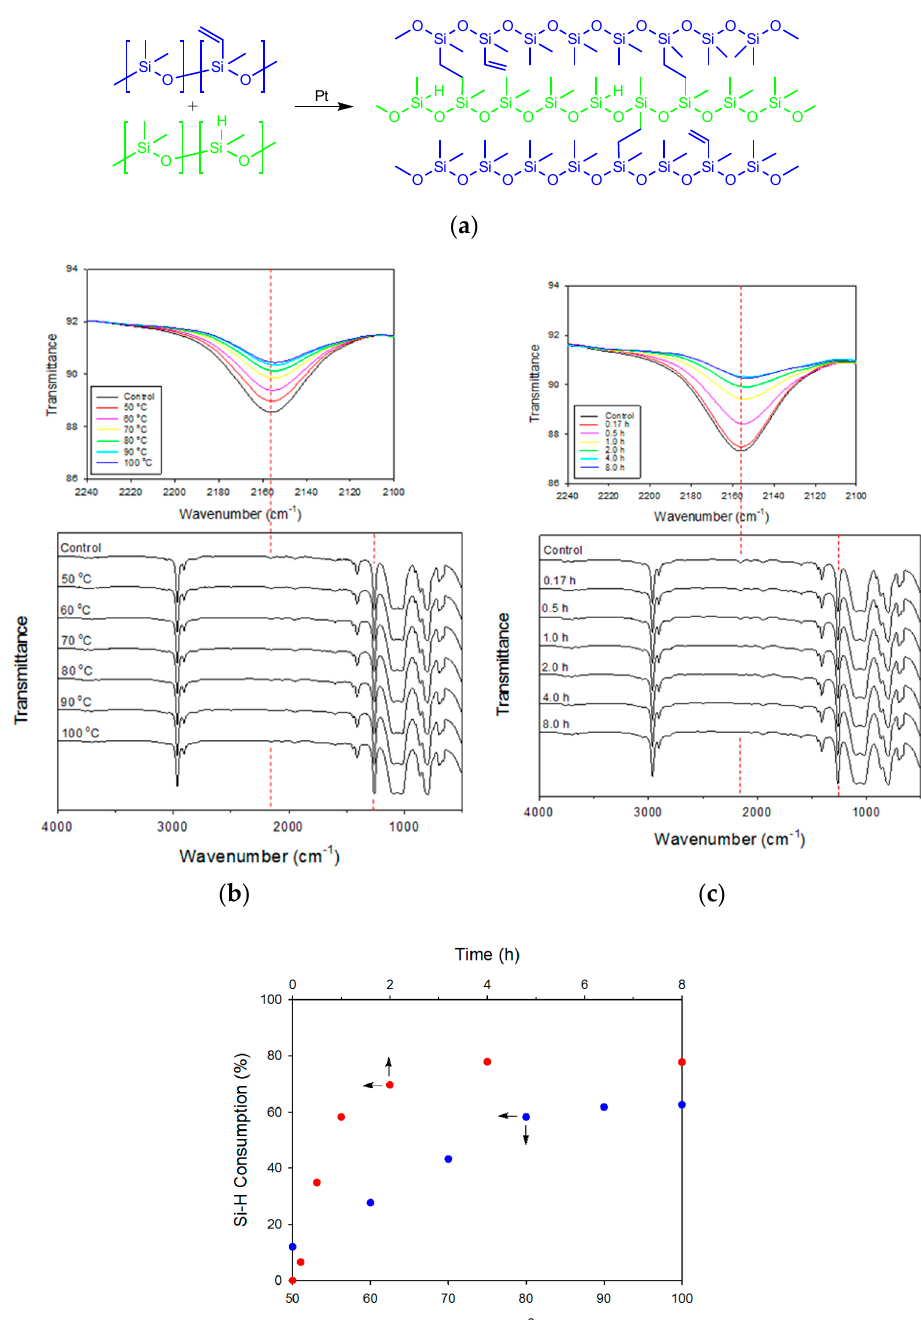
Figure 1. Schematically expressed crosslinking reaction between VPDMS and HPDMS ( a ). IR spectrum variation of a VH10 dope layer with curing temperature ( b ) and time ( c ). Degree of crosslinking calculated from the IR spectra ( d ).